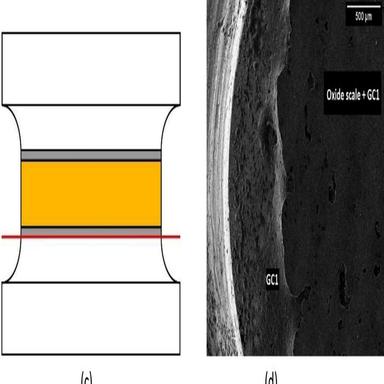
THG-5 joined sample tested at room temperature by glass-ceramic 1 (GC1): (a) polished cross-section; (b) typical fracture surfaces after torsion; (c) fracture propagation sketch (orange = glass-ceramic; grey = oxide scale; red = fracture propagation) showing the adhesive behavior, with glass-ceramic 1 (GC1) present on one fracture surface only, as observed in (d) by SEM-EDS, with each region identified (For interpretation of the references to colour in this figure legend, the reader is referred to the web v